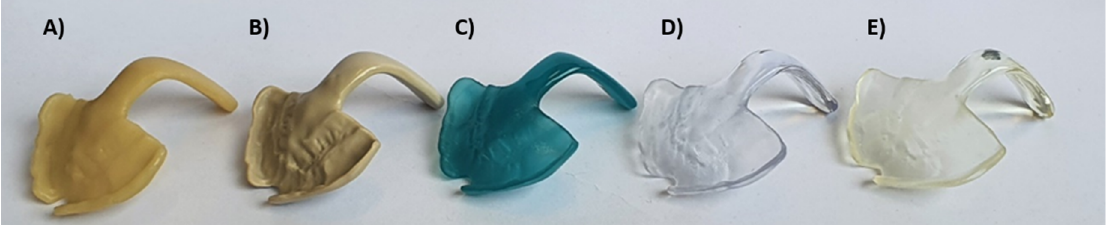
Figure 7. Examples of some of the tested TPPs of different computer-aided design (CAD)/CAM materials (without wire). SM materials: ( A ) Yamahachi PMMA color D4, ( B ) Smile PEEK; AM DLP materials: ( C ) Freeprint tray, ( D ) V-Print splint; AM SLA material: ( E ) Dental LT clear.